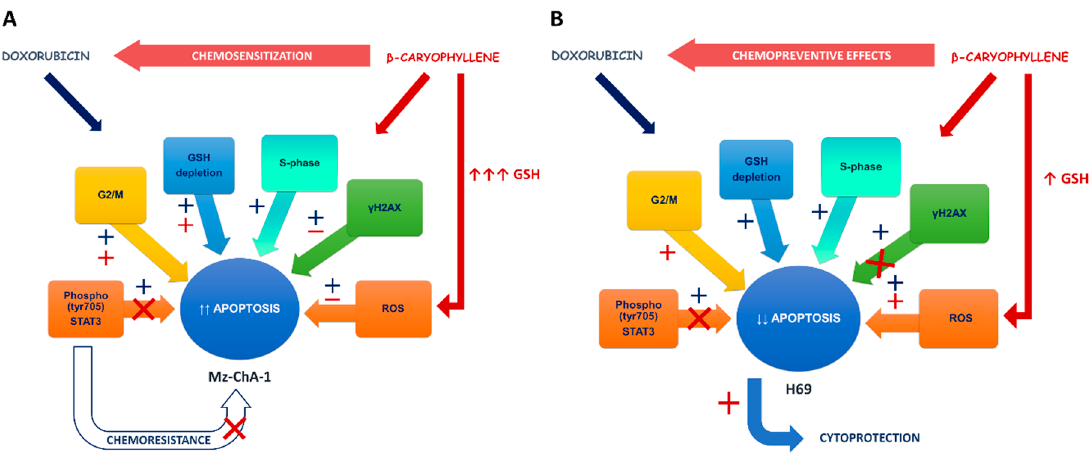
Figure 14. Scheme of the possible network involved in the chemosensitizing and chemopreventive e ff ects of β -caryophyllene towards doxorubicin in Mz-ChA-1 cholangiocarcinoma cells ( A ) and in H69 noncancerous cholangiocytes ( B ). Doxorubicin-induced oxidative stress, measured by the intracellular levels of reactive oxygen species (ROS), was partly reduced in combination with β -caryophyllene in Mz-ChA-1 cells, whereas GSH defenses, markedly upregulated by the sesquiterpene alone, were drastically reduced by both doxorubicin and its combination with β -caryophyllene, without a ff ecting GSSG amount. Conversely, in H69 cholangiocytes, despite a GSH depletion similar to doxorubicin and not correlated with an increase in GSSG, the combined treatment of doxorubicin and β -caryophyllene enhanced ROS levels with respect to both control and the anticancer drug alone, despite a slight increase of GSH by the only β -caryophyllene. γ H2AX, a biomarker of doxorubicin-induced DNA-damage, resulted partly lowered by the presence of β -caryophyllene in cholangiocarcinoma cells, with an almost complete inhibition in normal cholangiocytes. The increased G2 / M checkpoint phase by β -caryophyllene could allow to repair the doxorubicin-damaged DNA in H69 cholangiocytes. In both cell lines, the phosphorylation of STAT3 at tyrosine 705 site, induced by the anticancer drug, resulted markedly lowered by the natural sesquiterpene. These networking e ff ects result in an increased apoptotic fate in cholangiocarcinoma Mz-ChA-1 cells, despite an inhibition apoptosis in H69 noncancerous